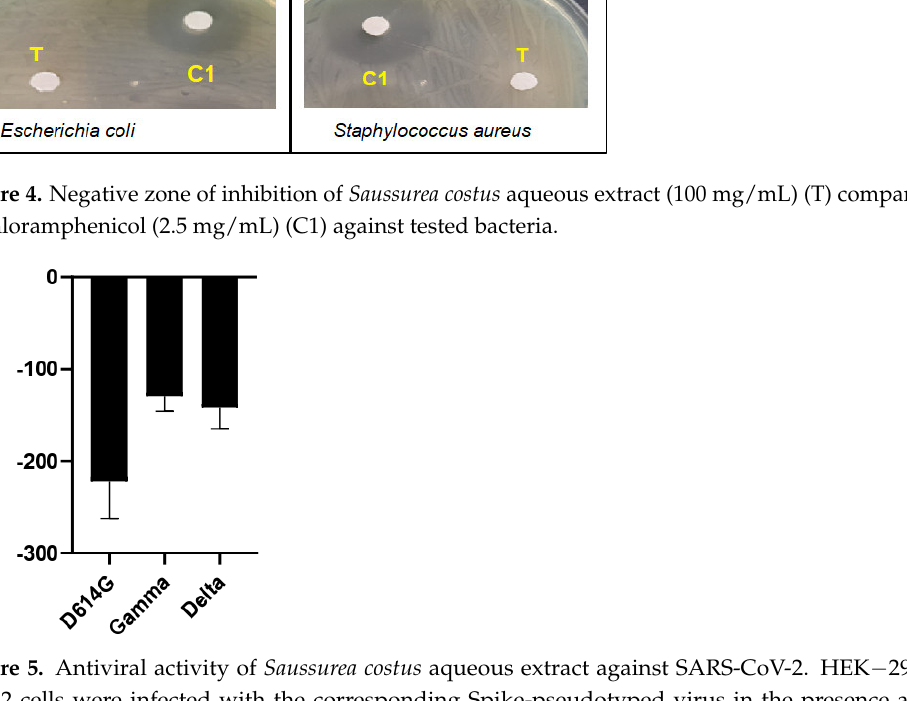
Figure 7. Time of addition assay of Saussurea costus aqueous extract . Vero cells were infected at MOI 1.5 and incubated with the extract at different times during the infection as is described in Section 2. After 24 h.p.i, the virus genome production was quantitated in the supernatant by qPCR. The % of inhibition was determined as the ratio between treated and untreated infected cells. Data are expressed as mean +/− SD for n = 3. The information presented here describes the chemical profiles of Saussurea costus derived from a green extraction procedure using a water-based solvent at ambient tem- perature. Eighty-four compounds were identified, including fatty acids, tannins, carbohy- drates, terpenoids, carboxylic acids, hydrocarbons, phenolic compounds, and sterols. The inhibitory effect of Saussurea costus on SARS-CoV-2 entry into the cell was studied using a pseudovirus with Spike proteins from the D614G variant and the VOC variants Gamma and Delta. Furthermore, the inhibition of the M pro by these compounds was investigated using the molecular docking approach. Twenty-two candidates showed a good affinity to bind with the active site of the M pro . According to this study, twenty-two candidates were